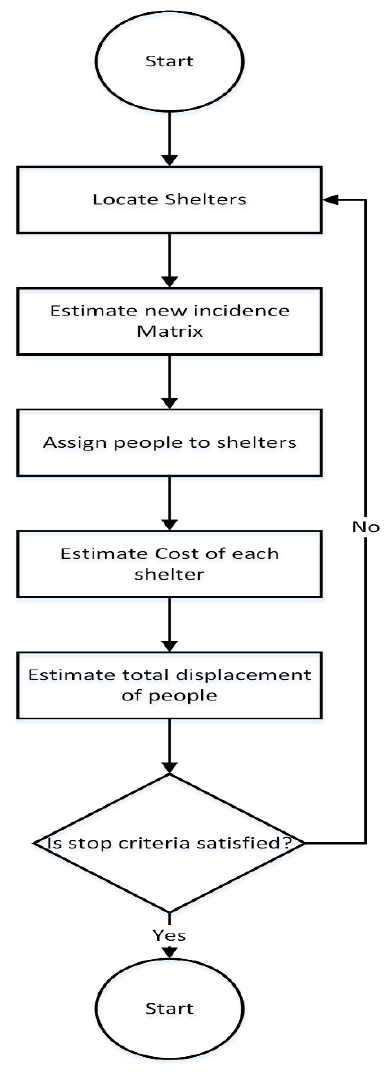
Fig. 1: Flowchart of the suggested method